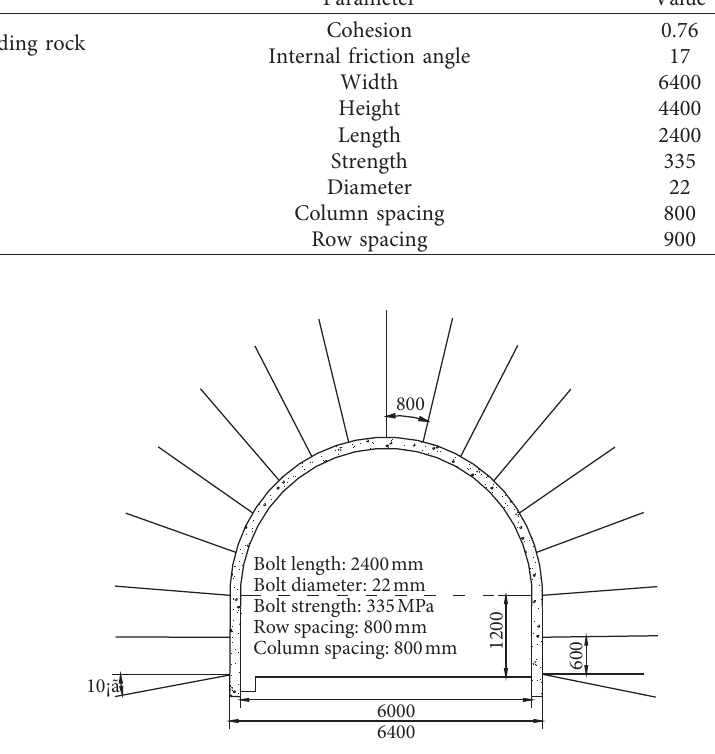
Figure 5: New support parameter of inclined